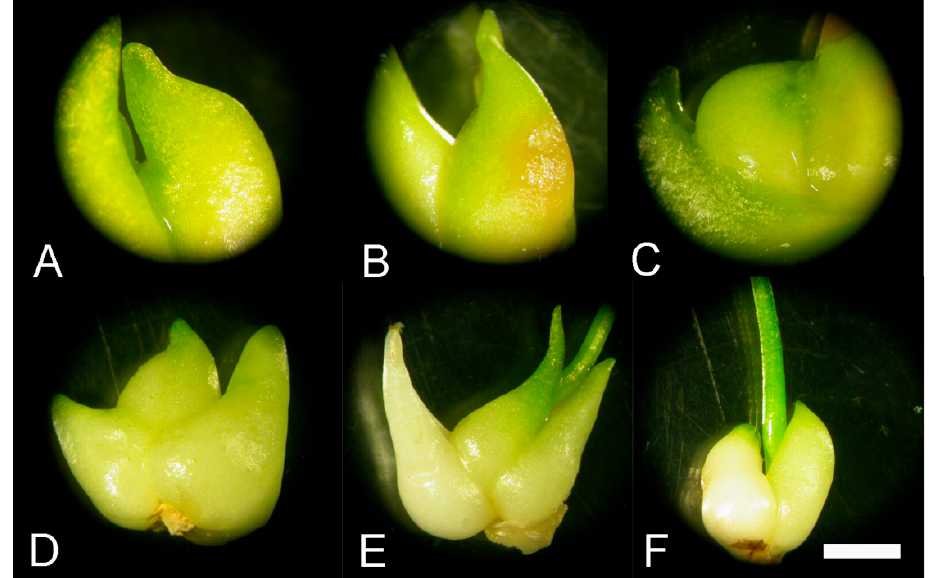
* Values represent average percentage of sprouted bulbs (%) ± SE. Different letters within columns indicate significant differences between treatments at p < 0.05 (LSD test).